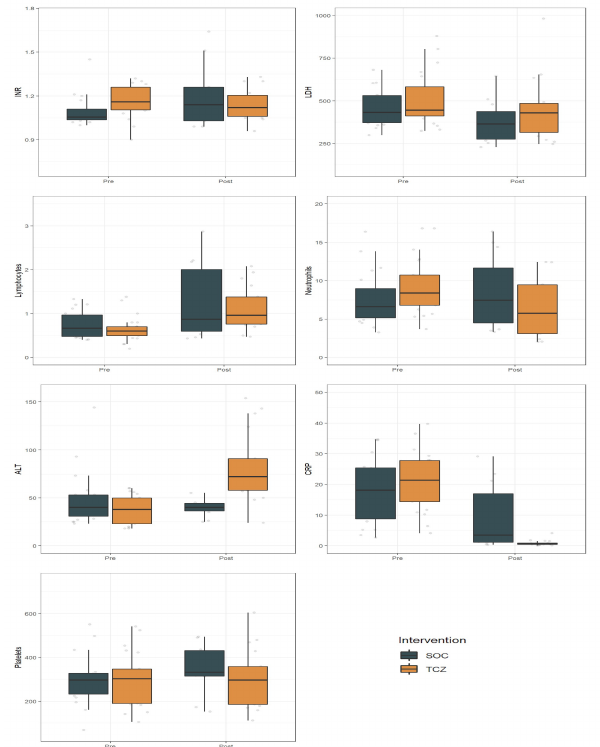
Figure 1. E ff ect of Tocilizumab (TCZ) on the laboratory measures compared with Standard of Care (SOC). Data are presented pre- and post-treatment, representing day 0 and day 7, respectively. Abbreviations: SOC, Standard of Care; INR, International Normalized Ratio; LDH, lactate dehydrogenase; ALT, alanine aminotransferase; CRP, C-Reactive Protein; PLT,